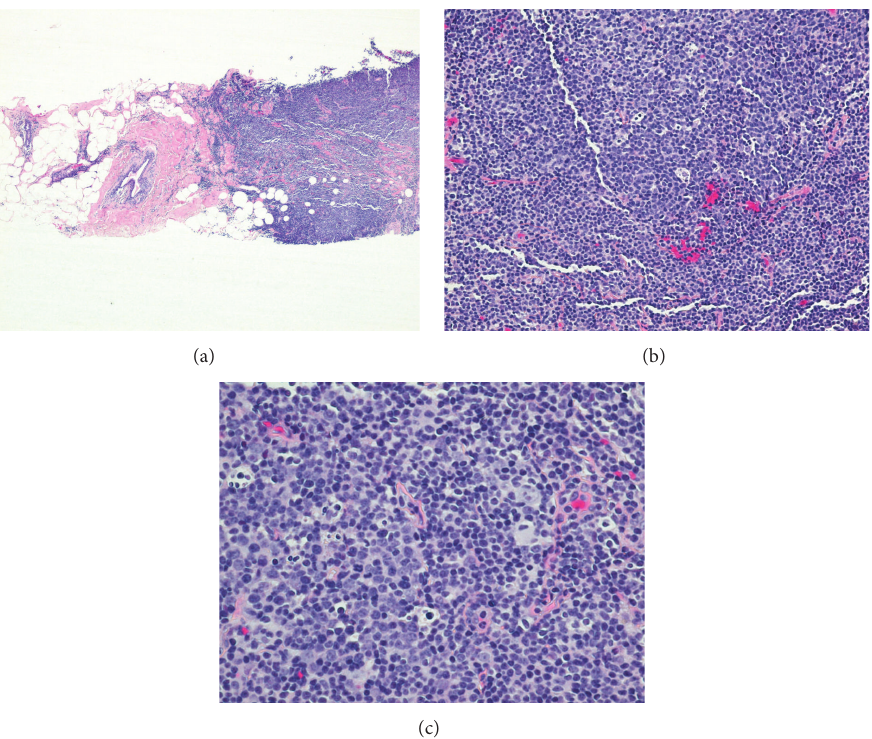
Figure 1: Low and high power images of H&E stain show infiltration of the breast tissue by lymphocytes of MALT lymphoma. These lymphocytes have abundant pale cytoplasm leading to monocytoid features.